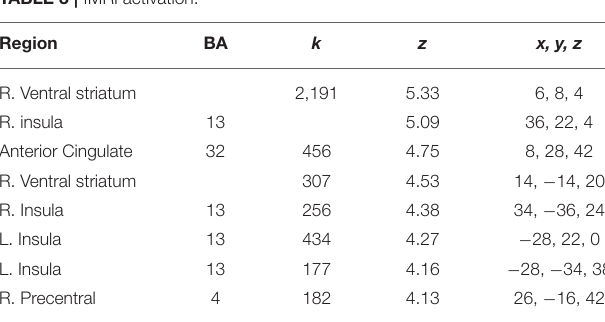
TABLE 3 | fMRI activation.